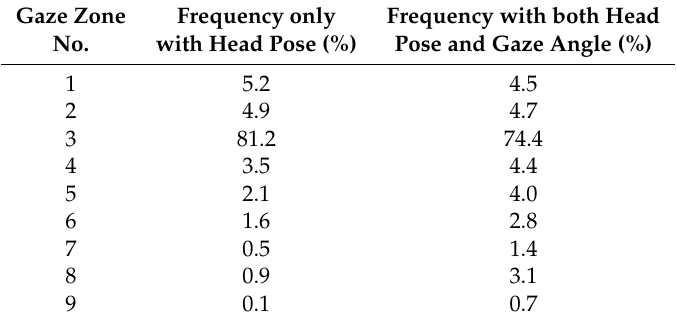
Table 5. Frequency value of each gaze zone estimation.